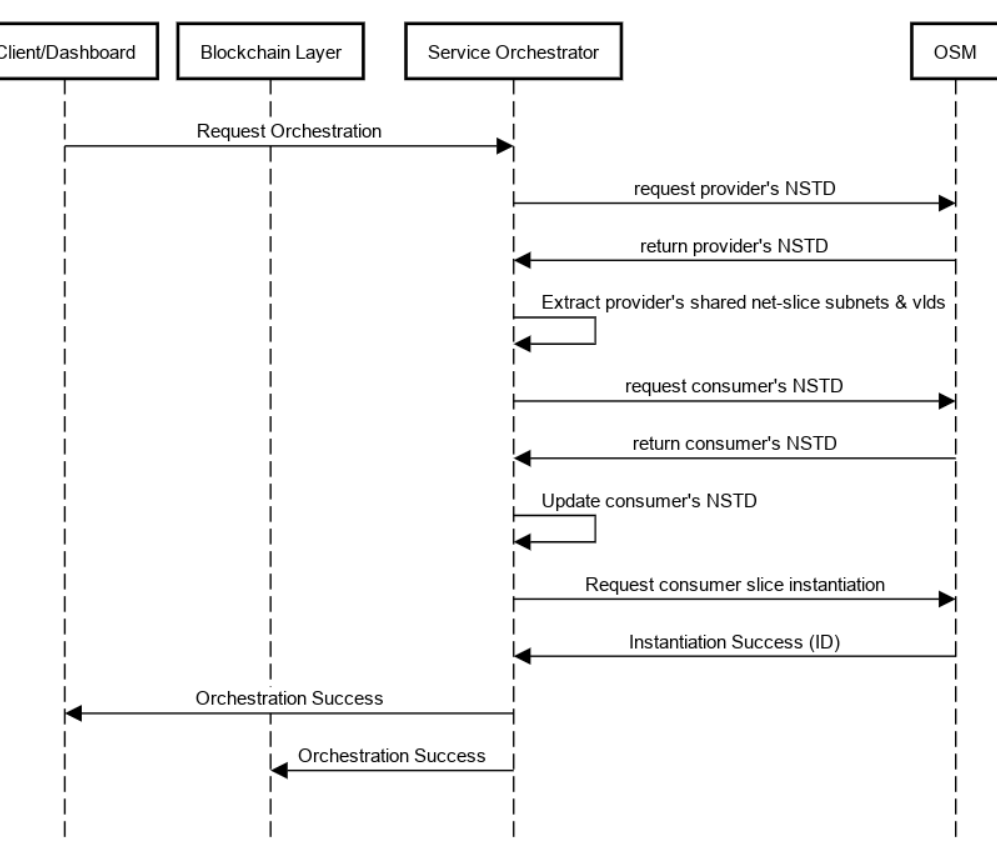
Figure 4. CSC interactions and